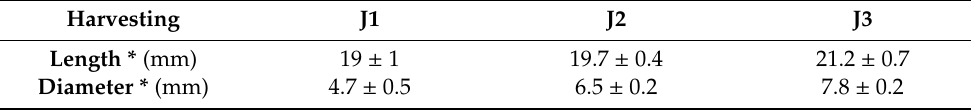
Table 1. Length and diameter of jujube fruits ( Ziziphus jujuba Mill.) during ripening.